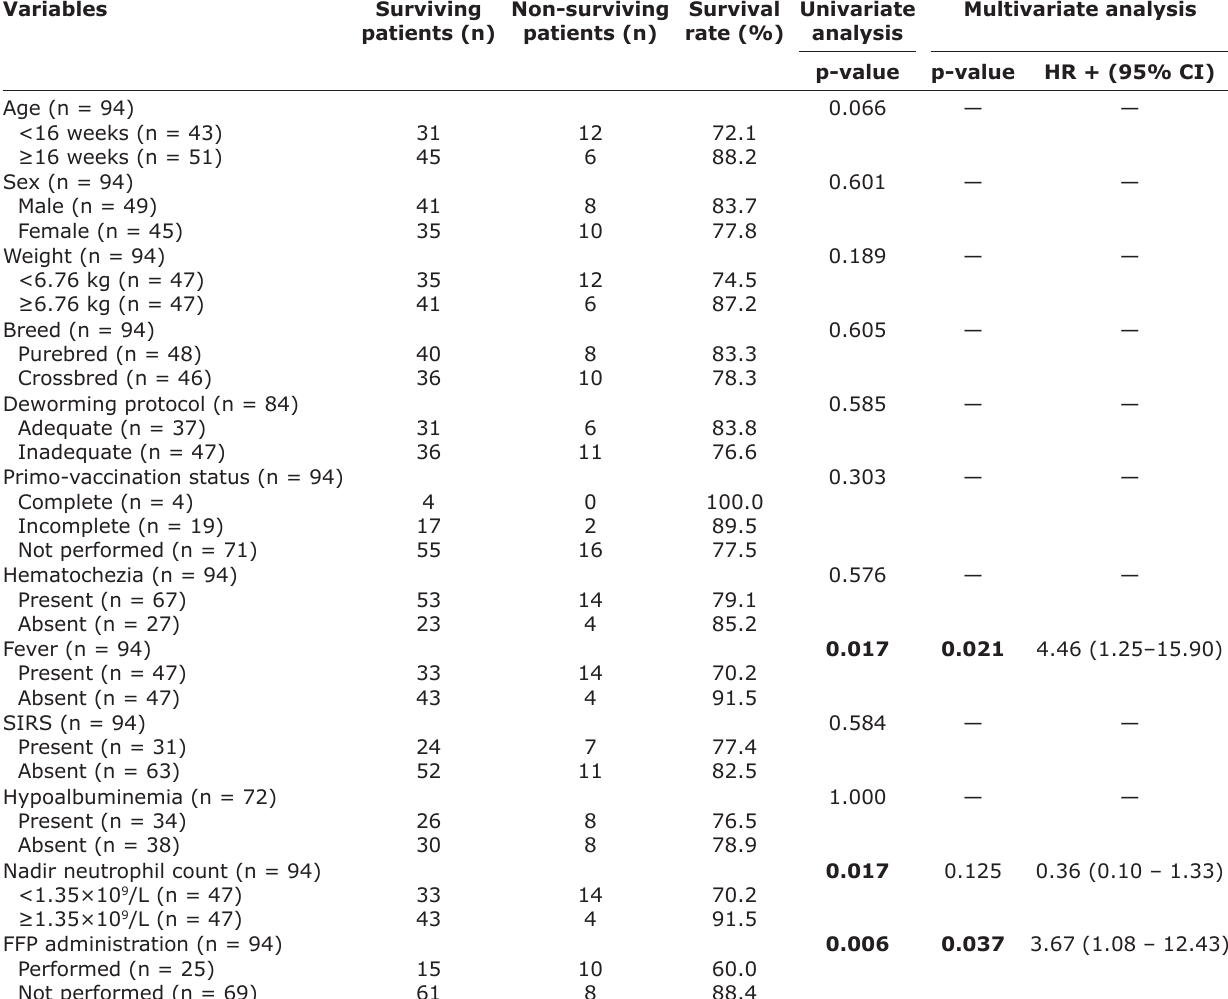
Table-1: Association between patient signalment, clinical presentation, and treatment with outcome (surviving vs. non-surviving patients) in 94 dogs diagnosed with presumptive acute viral gastroenteritis from two referral hospitals in the northern region of